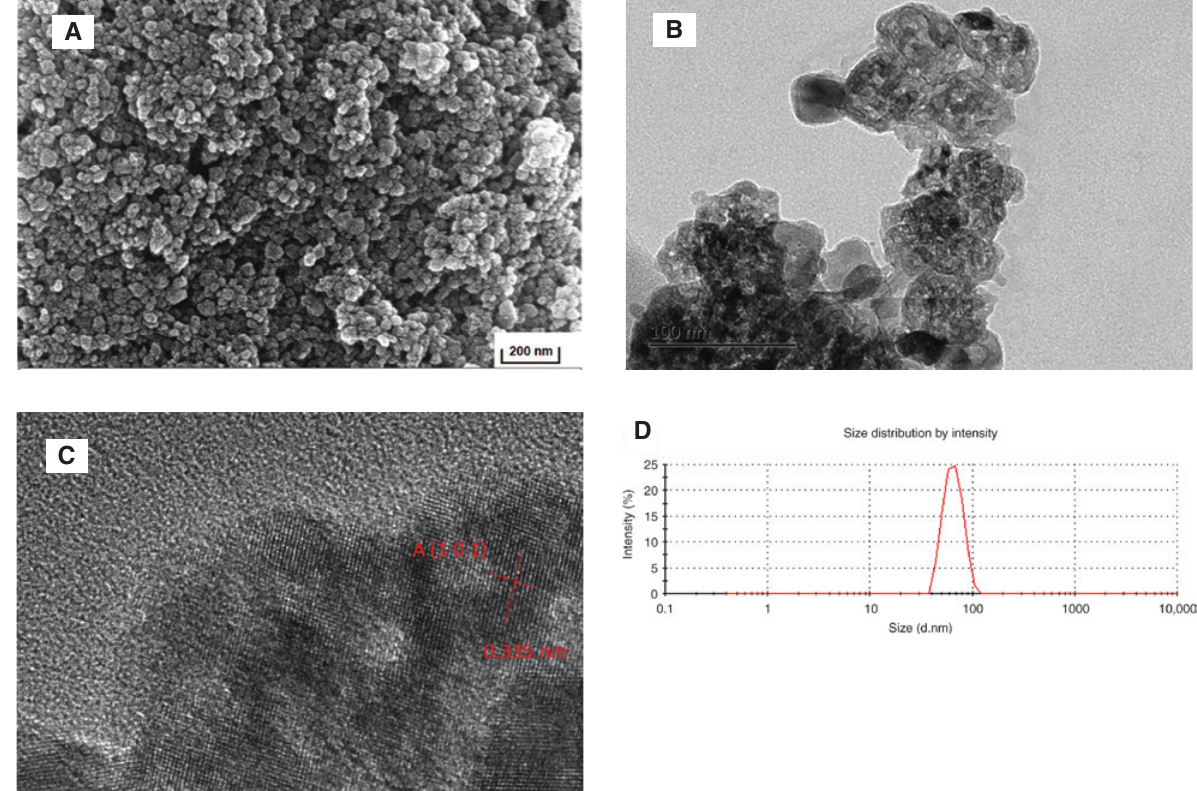
Figure 3: The FESEM and HRTEM micro-morphologies of the product shown in Figure 2A. (A) FESEM image, (B and C) HRTEM images, (D) laser particle size analysis result.